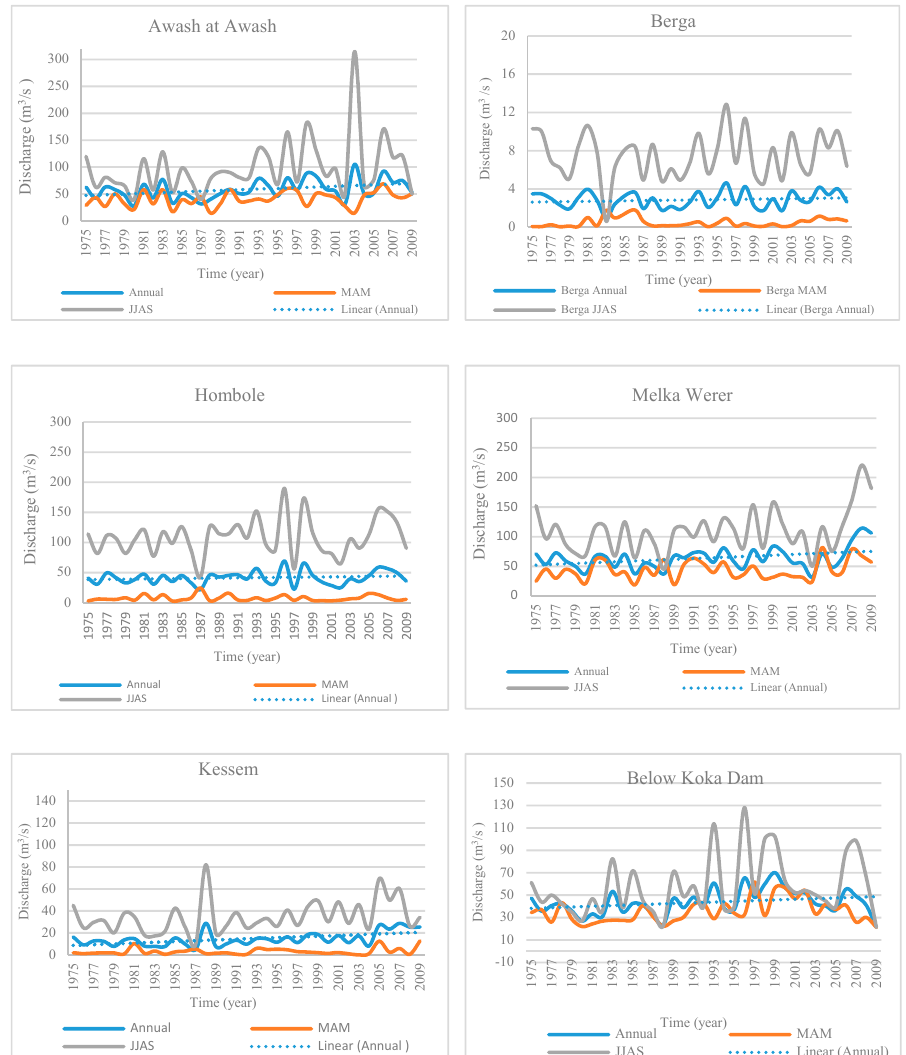
Figure 9. The temporal variability in the annual and seasonal streamflow in the ARB, (Group 1) (1975–2008).